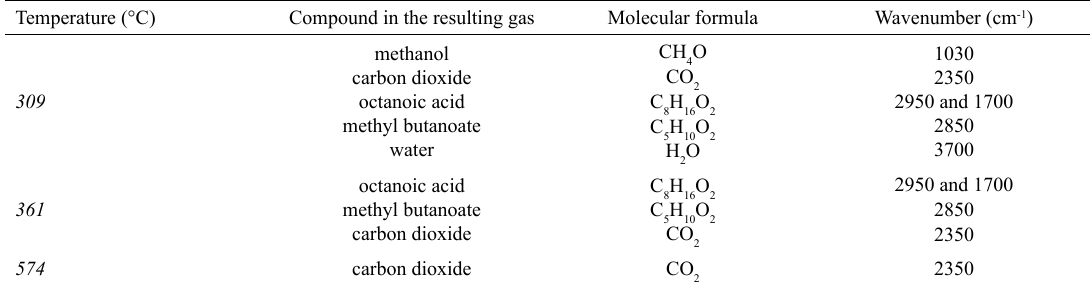
Table 2. Compounds present in the resulting gas at each thermal event of the jute fibre thermal analysis. Temperature